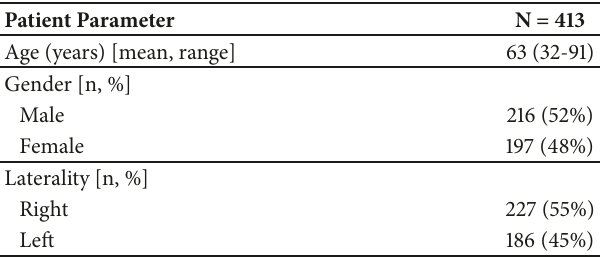
Table 1: Descriptive statistics of patient